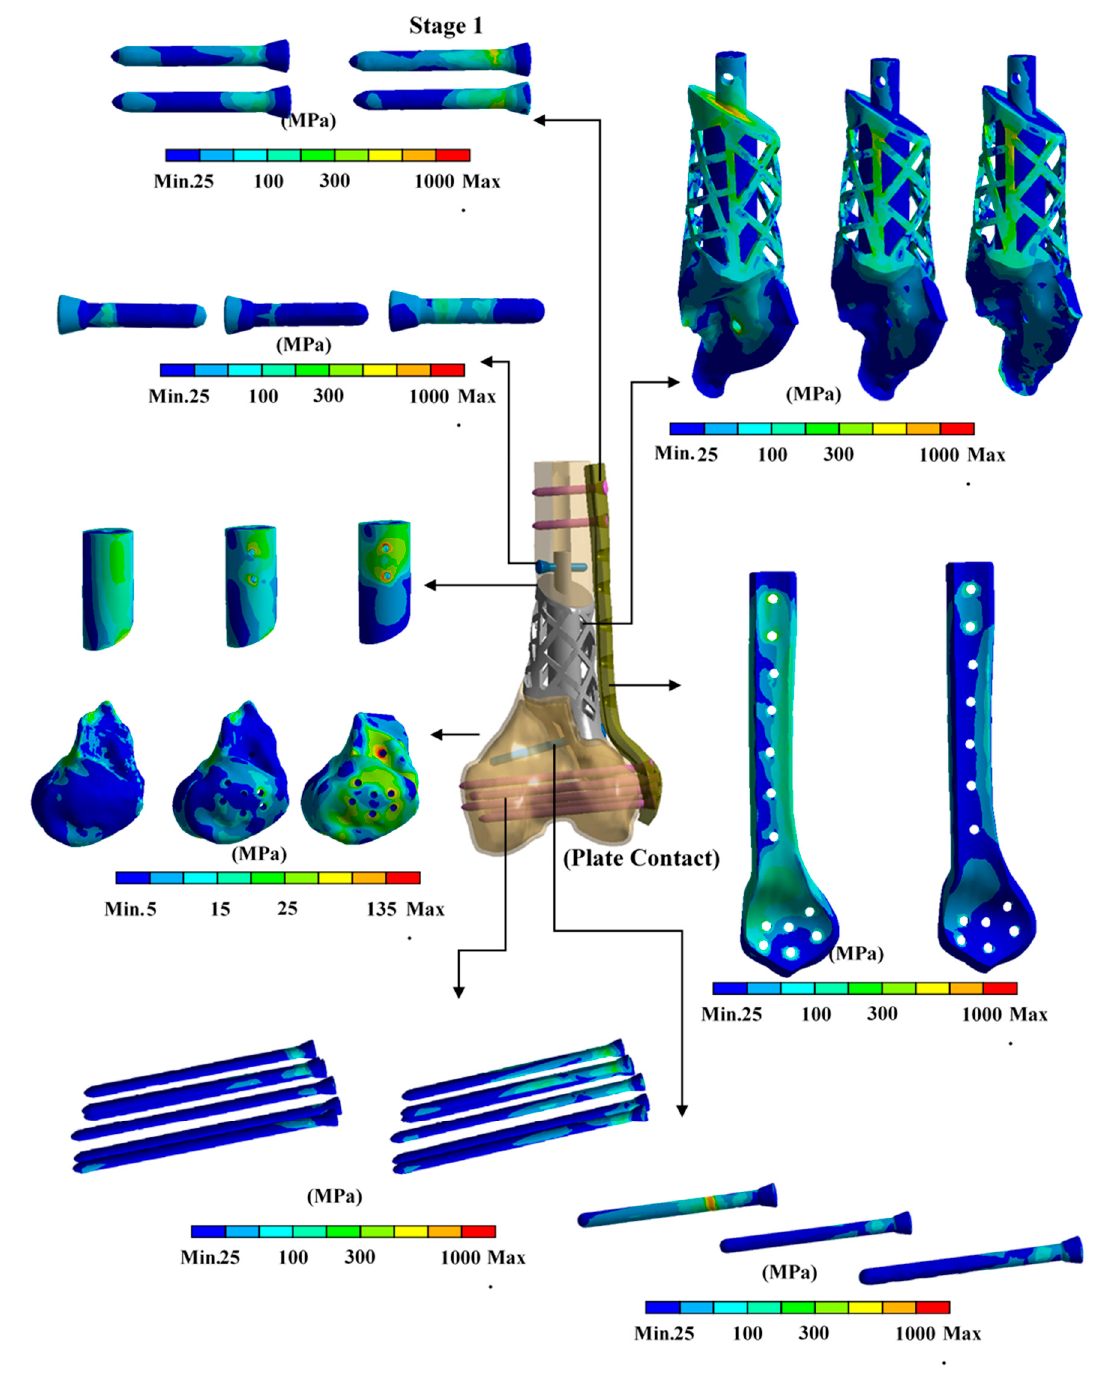
Figure 5. The maximum stress distribution area in the stage 1 occurred at the surface lattice mesh structure with apex region / implant stem for the implant, at the bone-implant interface for the bone, the implant screws, the locking plate and the locking plate screws. Significant decrease of stress can be observed with progress into the second and third stage.